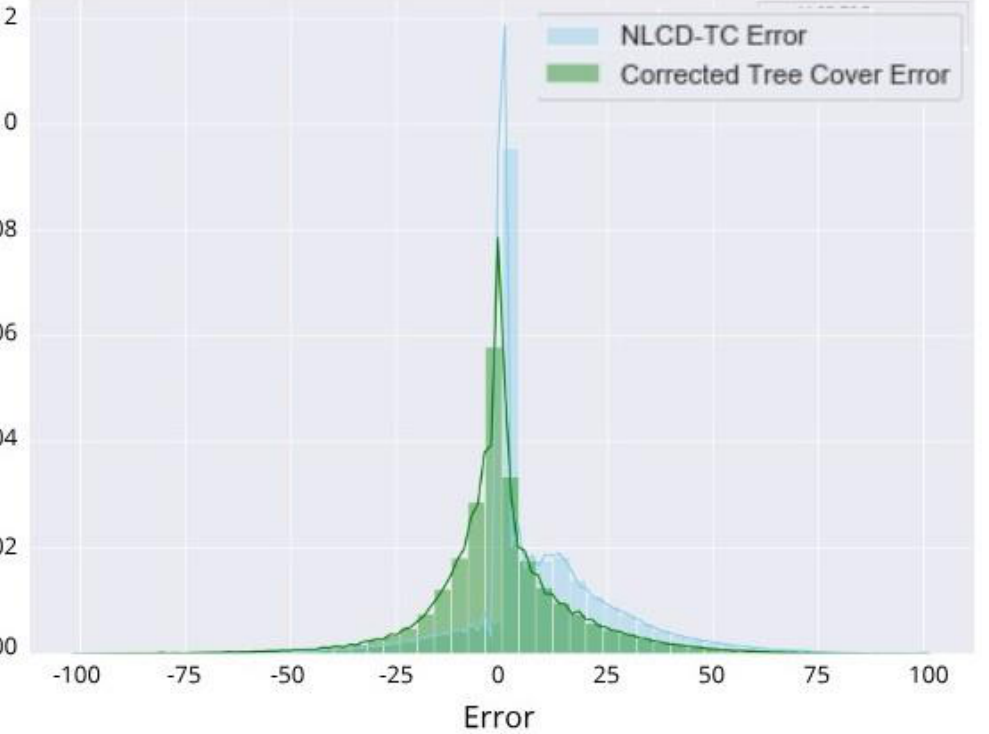
Figure 9. Comparison of National Land Cover Database-Tree Cover, predicted tree cover, and high- resolution derived TC tree cover histograms; the smoothed lines show the normal density line; the Y axis shows the percentage of data counts. Table 3. Summary predictive model output.